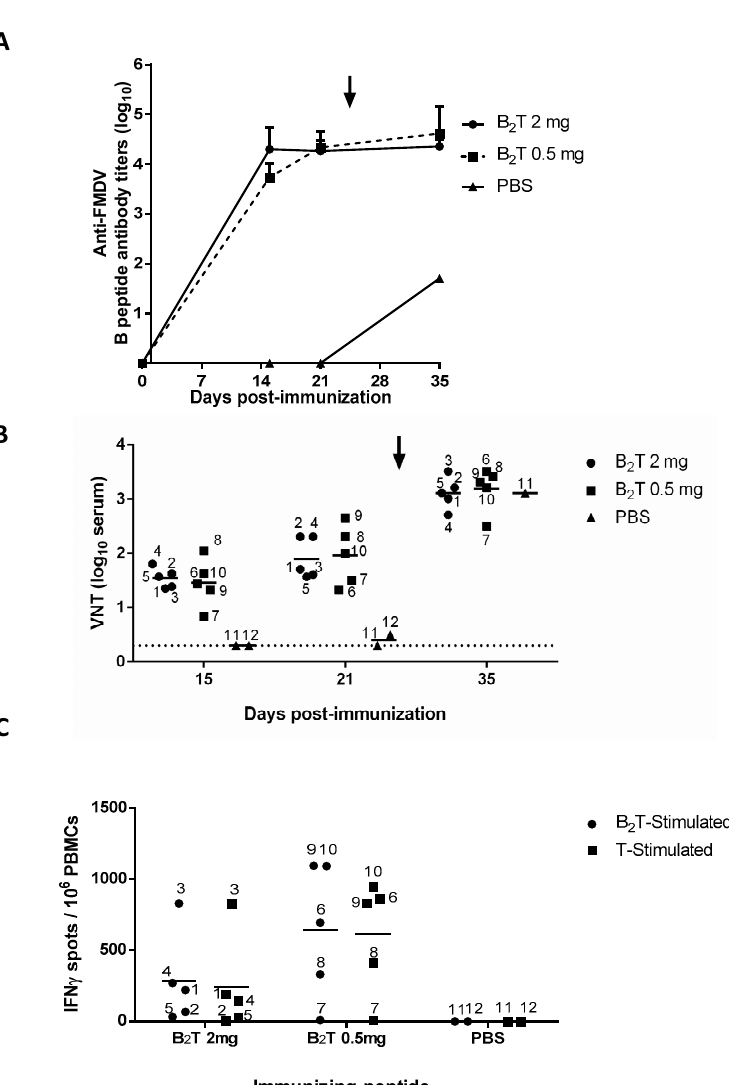
Figure 1. B- and T-cell responses in pigs immunized with a single dose and different amounts of B 2 T. Time course of the specific antibody responses in sera collected on the indicated days pi. ( A ) Total anti peptide B IgG titers analyzed by ELISA. Each point depicts mean antibody titers (calculated as described in Methods) ± SD for each group of pigs ( n = 5). ( B ) Virus neutralization titers, VNT, expressed as the reciprocal log10 of the last serum dilution that neutralized 100 TCID50 of FMDV isolate O / UKG 11 / 01. Each symbol represents the value for an individual pig (numbering is included). Horizontal lines indicate the geometric mean for each animal group. In no case individual spontaneous reactivity was observed in the titers determined at day 0. Dotted lines denotes the assay detection limit. In ( A , B ) arrows point FMDV challenge (day 25 pi). ( C ) Specific T-cell responses measured by an ex vivo IFN- γ ELISPOT at days 15 pi. The frequency of FMDV-specific IFN- γ secreting cells was determined as detailed in Methods. Horizontal bars represent the mean frequencies of IFN- γ release spots of triplicates of peripheral blood mononuclear cells (PBMCs) from pigs stimulated in vitro with B 2 T (circles) or T (T3A) (squares) peptides (pig numbering is